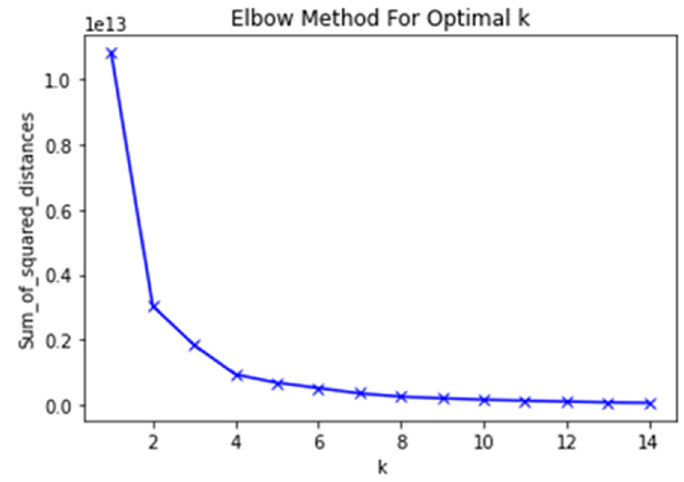
Figure 4. Elbow analysis plot for PAH patients’ data—determining an optimal number of clusters. The point where the curve is becoming flat—in this case, it is 4—determines the optimal number of clusters.